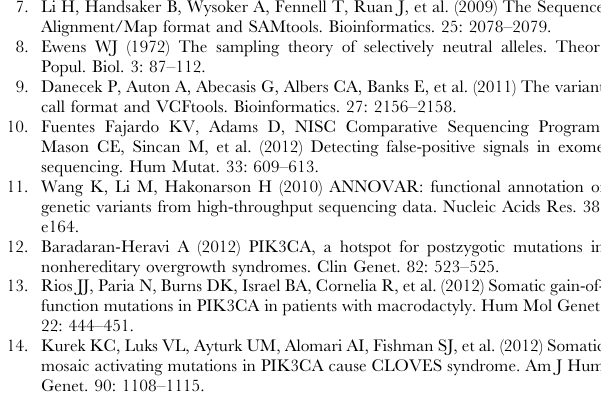
Figure S2 Variants identified in sample 3 by the full and flat AFS models including the causal variant in PIK3R2. (TIF) Figure S3 Evaluation of all exome analyses using simulated data. (A) Minimum mutant allele frequencies for identification of a simulated variant at total read depths ranging from 4 to 100. (B) Base call accuracies of a simulated variant identified at the minimum mutant allele frequency. Table S1 Coverage statistic. Table S2 Sequence and data quality characteristics of tier 1 variants identified by the default and alternative exome analyses. Table S3 Variant details for genes with novel tier 2 variants in two or more patients. Table S4 Number and sequence properties of unique tier 2 identified by the AFS flat